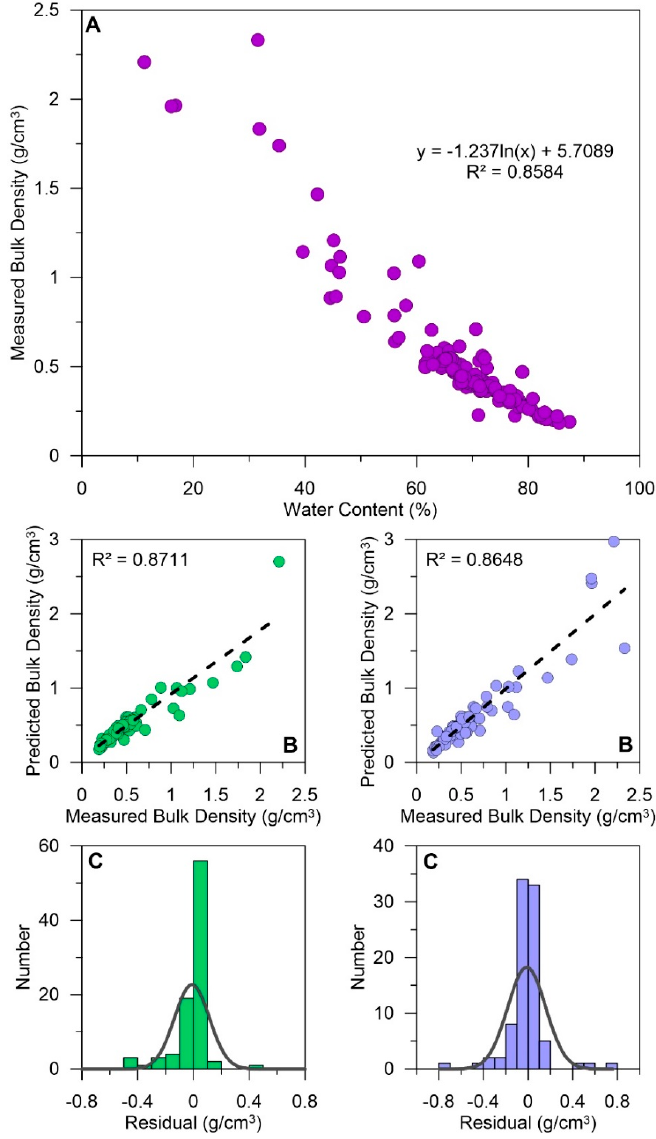
Figure 5. Water content and bulk density in Uinta lake sediments. ( A ) Relationship between water content and bulk density. ( B ) This dataset was randomly split in half (twice) and the two halves were used to test the robustness of the relationship. In both cases, moisture content proved to be a valid predictor of bulk density. ( C ) Residuals were <0.2 g/cm 3 when predicted values were compared with measured